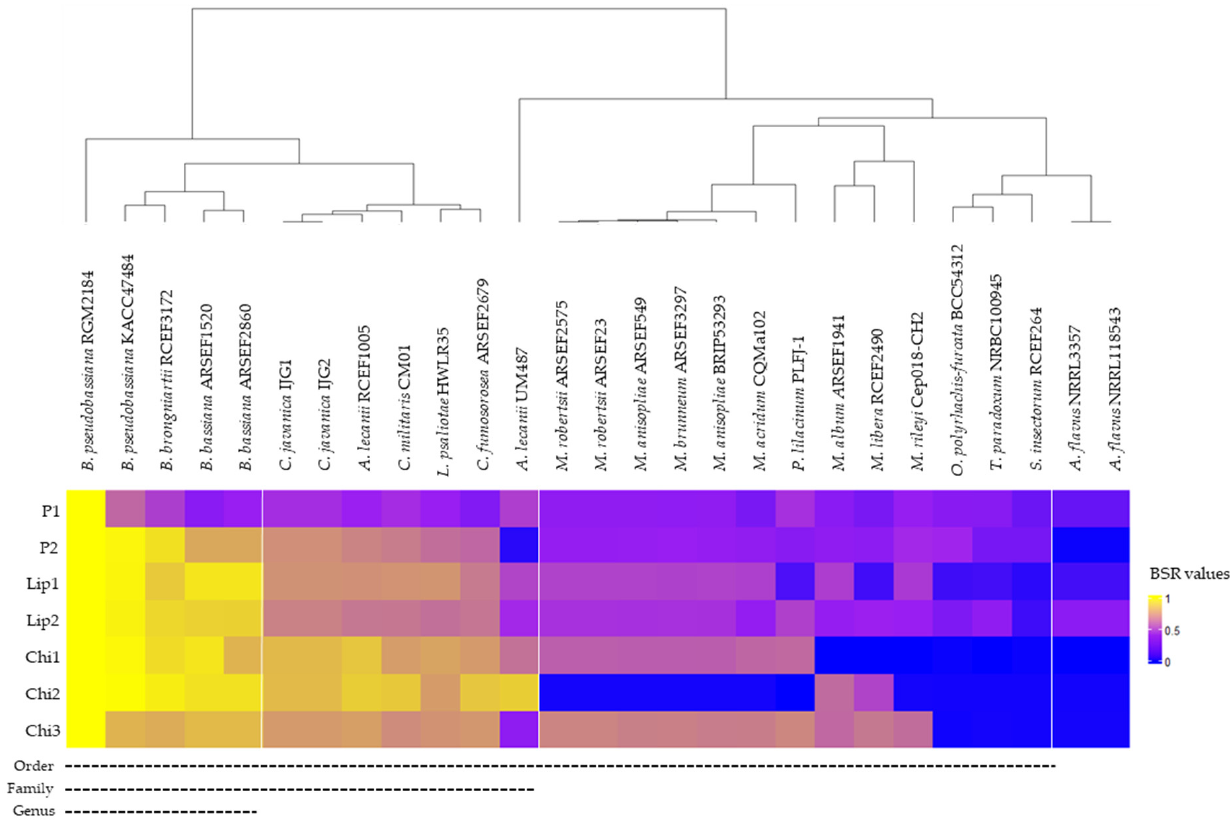
Figure 5. Heat map displaying similarity degree between identified exoenzyme of B. pseudobassiana RGM 2184 in comparison to other entomopathogenic fungi. A score of 1 indicates a perfect match and a score of 0 indicates no BLAST match for a query enzyme in the reference genome. Values greater than 0.4 indicate the presence of a homologous enzyme. Segmented lines indicate that EPF strains share the same taxonomic level.